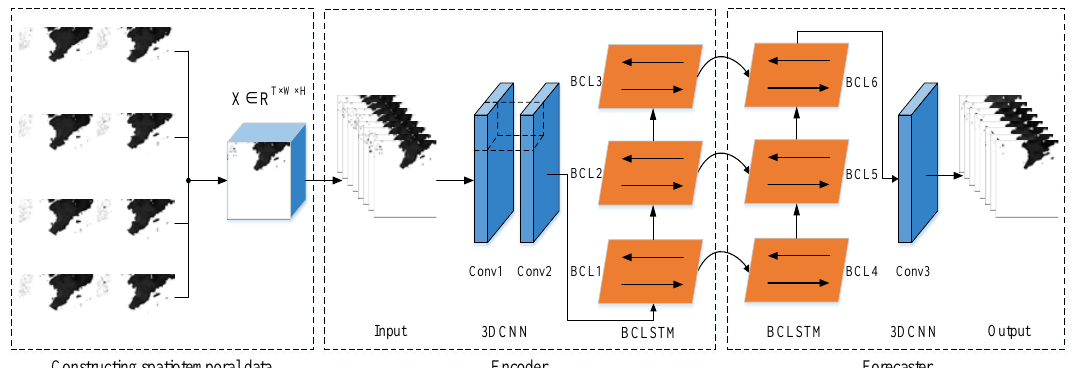
Figure 1. Model structure of 3DCNN-BCLSTM.